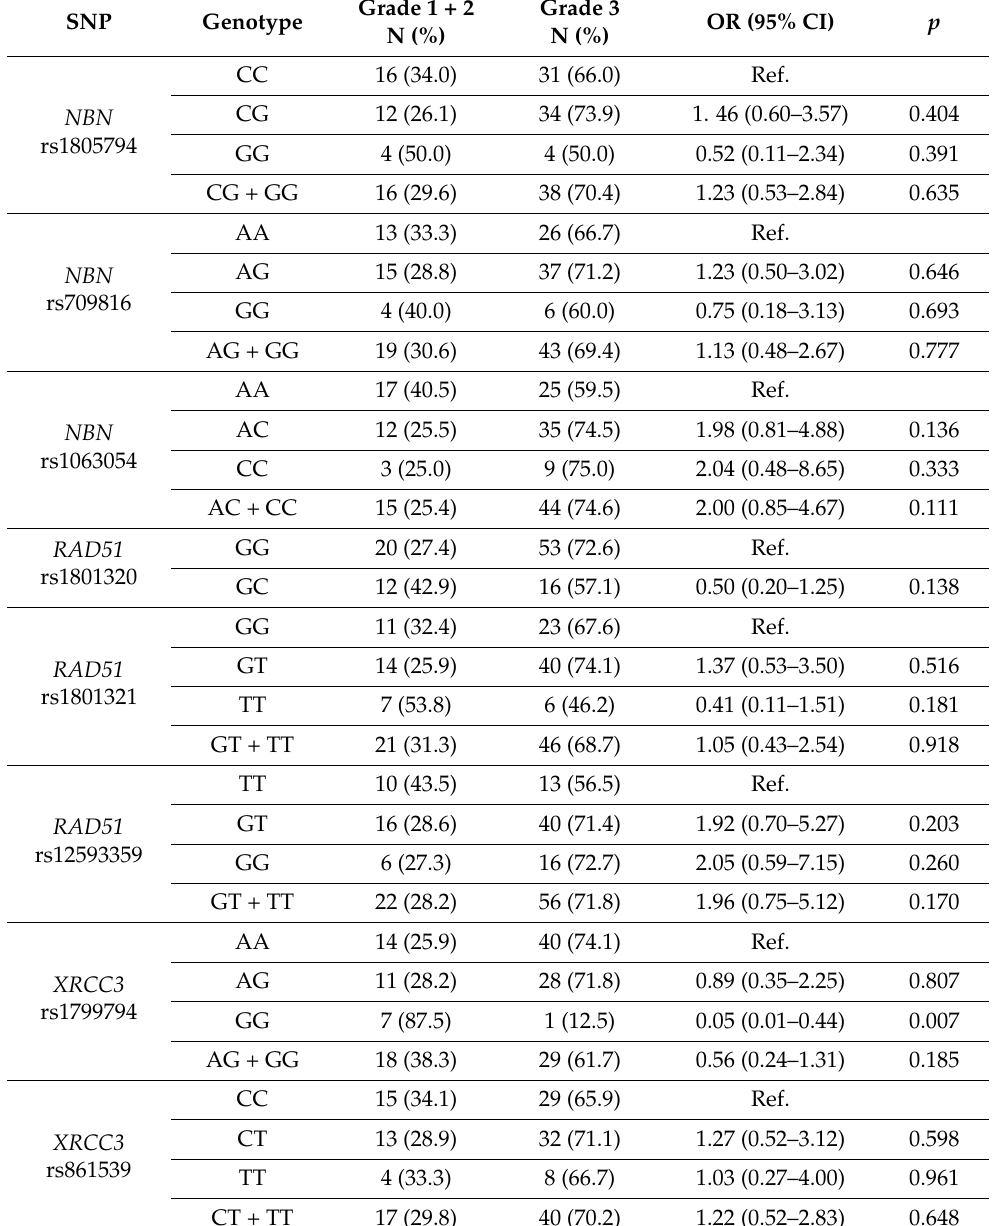
Table 5. Association of investigated polymorphisms in HRR genes with tumor differentiation